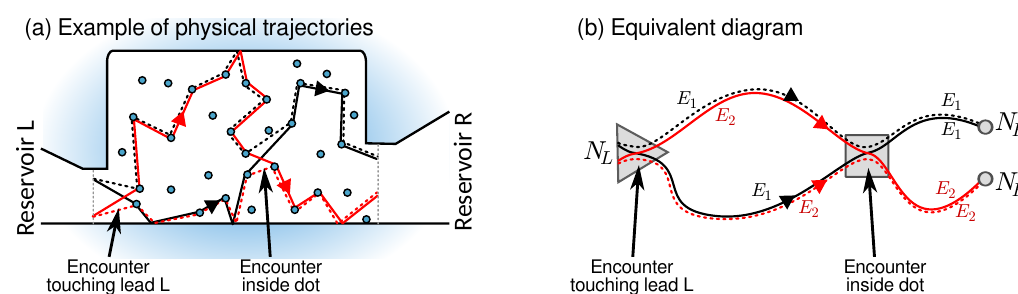
Figure 4: This sketch indicates how to go from (a) physical trajectories in an disor- dered open dot to (b) the slightly more abstract diagrams used to calculate the trans- port properties, such as the diagrams in Figs. 5 and 6. The equivalent for chaotic systems are trajectories which bounce back and forth inside the dot, but when un- folded look similar to the diagrams in (b), with paths diverging and converging from each other. In (b) we use a triangle to indicate an encounter that touches a lead, and a rectangle to indicate an encounter inside the system; this notation is carried over into Figs. 5 and